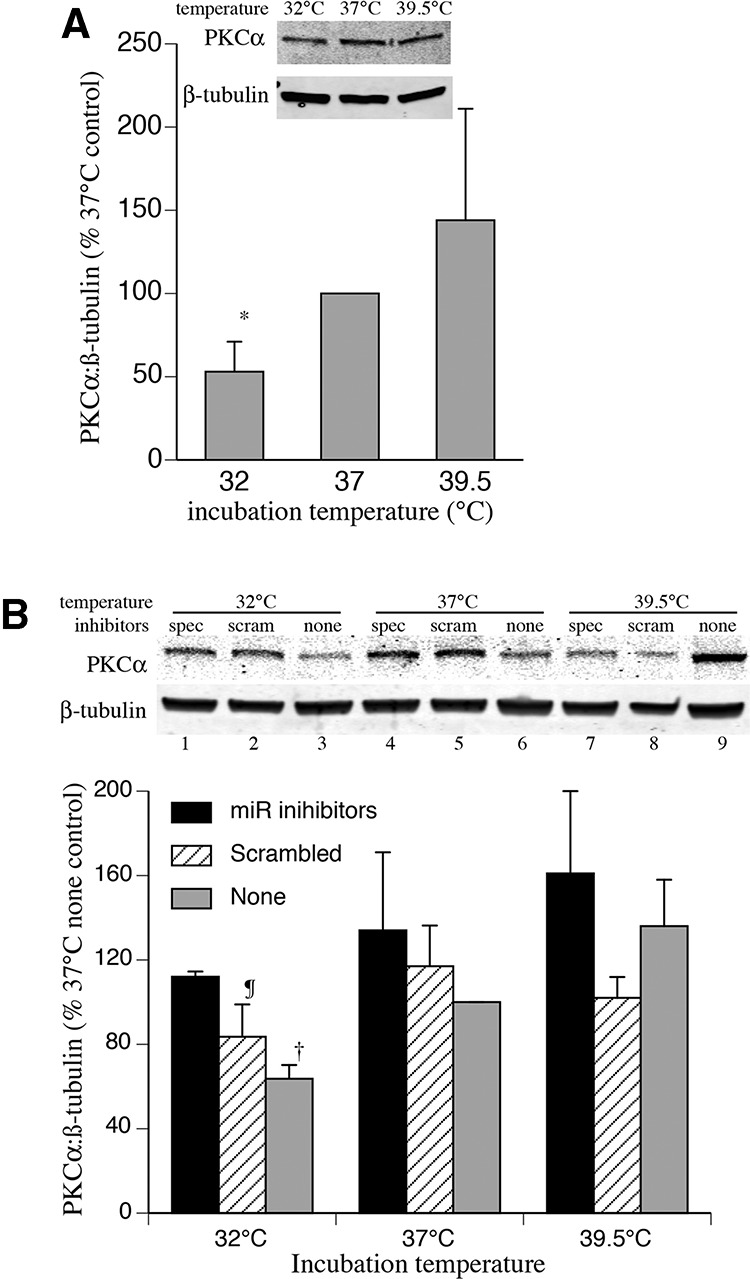
Clinically relevant temperature change-induced expression of miRNAs alters the PKCα protein levels. (A) Human SAECs were incubated at 32°C, 37°C, or 39.5°C for 24 h and cell lysates were immunoblotted for PKCα. Representative of four similar blots and quantified band densities for PKCα normalized to β-tubulin and expressed as percent of levels in 37°C cells. (B) HEK 293T cells were transfected either with a combination of miRNA inhibitors against hsa-miR-27b-5p, hsa-miR-1260a, and hsa-miR-92a-1-5p or an equal concentration of a non-targeting scrambled-sequence inhibitor control. Transfected and untransfected cells were incubated at 32°C, 37°C, or 39.5°C for 24 h and immunoblotted for PKCα. A representative immunoblot and quantified band densities from four similar blots normalized to ß-tubulin and expressed as percent of levels in untreated 37°C cells are shown. Mean ± SEM. (*) P < 0.05, (†) P < 0.04 versus untreated 37°C and 39.5°C cells and miRNA inhibitor-treated 32°C cells, (¶) P < 0.02 versus untreated 39.5°C cells; n = 4.